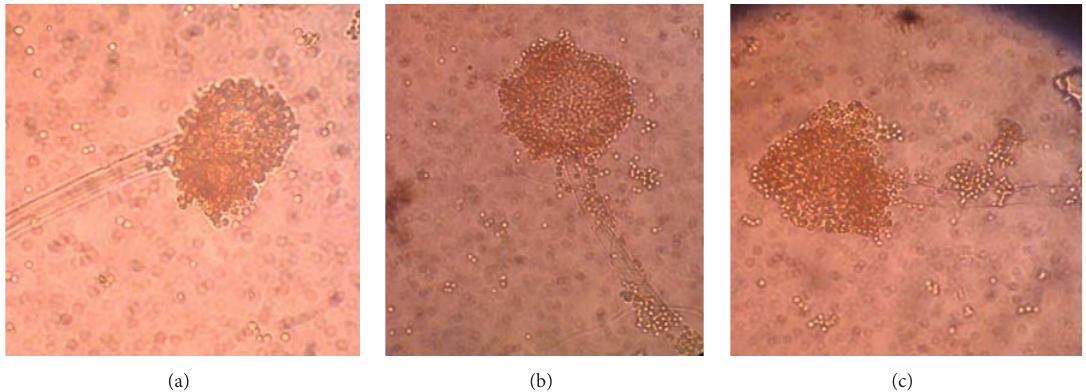
Figure 3: A wet preparation of Aspergillus niger showing “sporing structure.” ((a) and (b)) From hands of school children, (c) from soapy